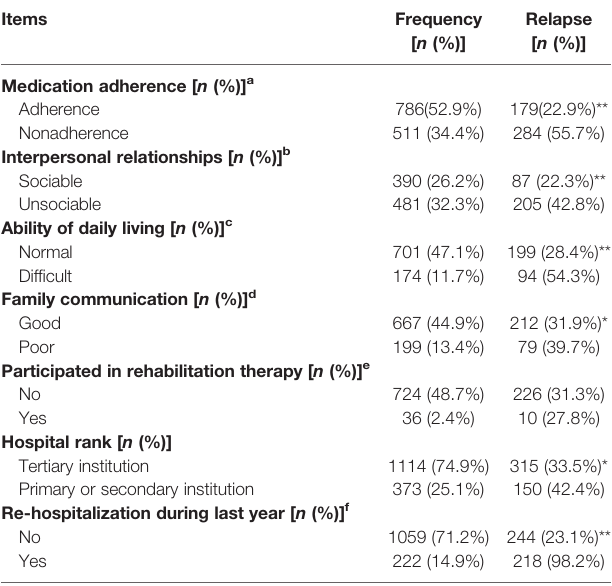
TABLE 1-4 | General demographic and disease information of the patients